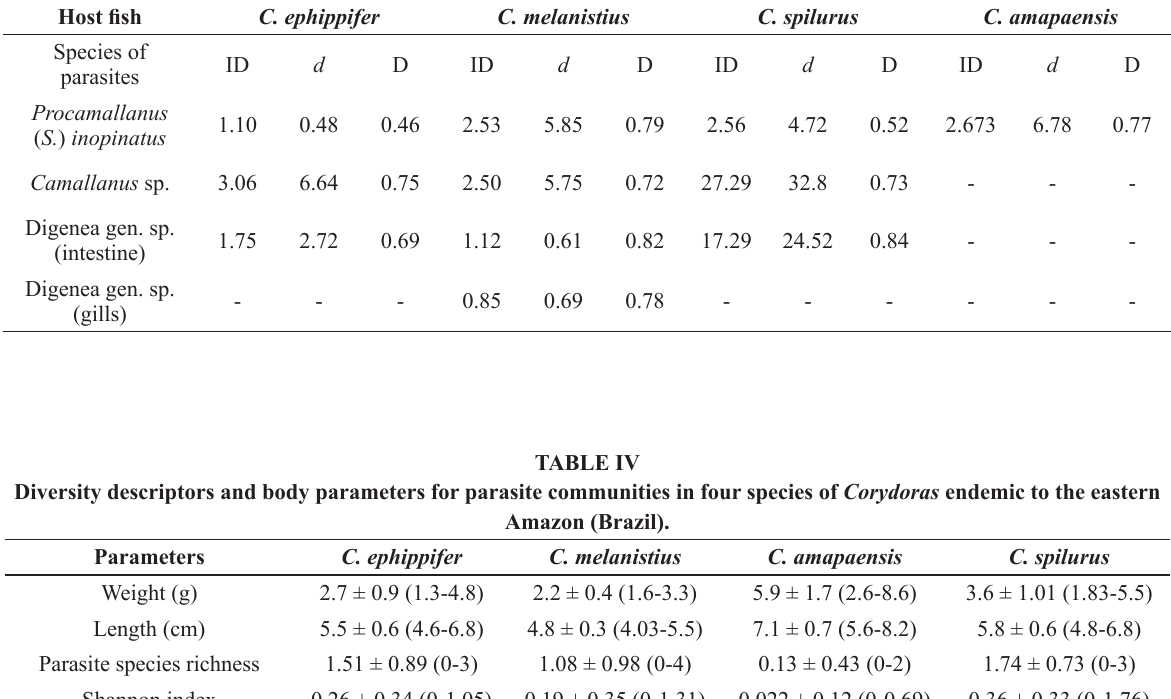
Index of dispersion (ID), d- statistic and discrepancy index (D) for the parasite infracommunities of four species of Corydoras endemic to the eastern Amazon (Brazil).